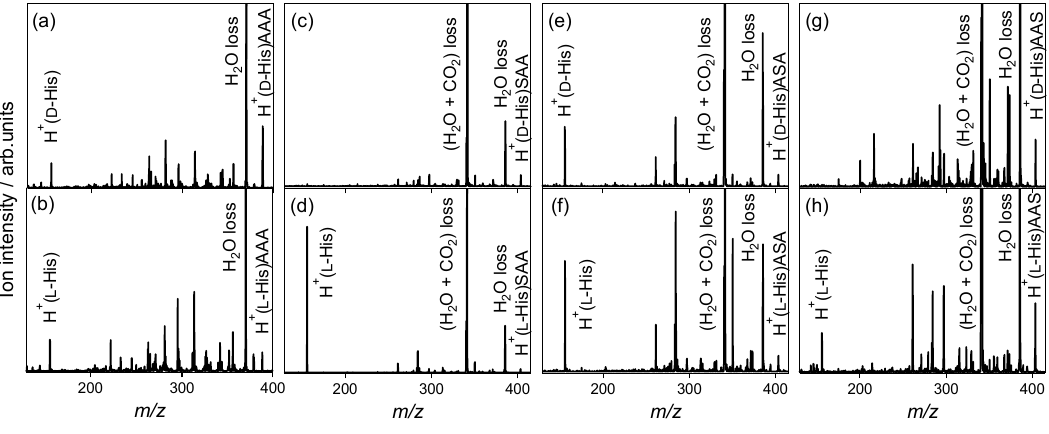
Figure 5. Collision-activated dissociation spectra of protonated noncovalent complexes of histidine with L -alanine and L -serine-containing tripeptides: ( a ) H + ( D -His)AAA, ( b ) H + ( L -His)AAA, ( c ) H + ( D -His)SAA, ( d ) H + ( L -His)SAA, ( e ) H + ( D -His)ASA, ( f ) H + ( L -His)ASA, ( g ) H + ( D -His)AAS, and ( h ) H + ( L -His)AAS.